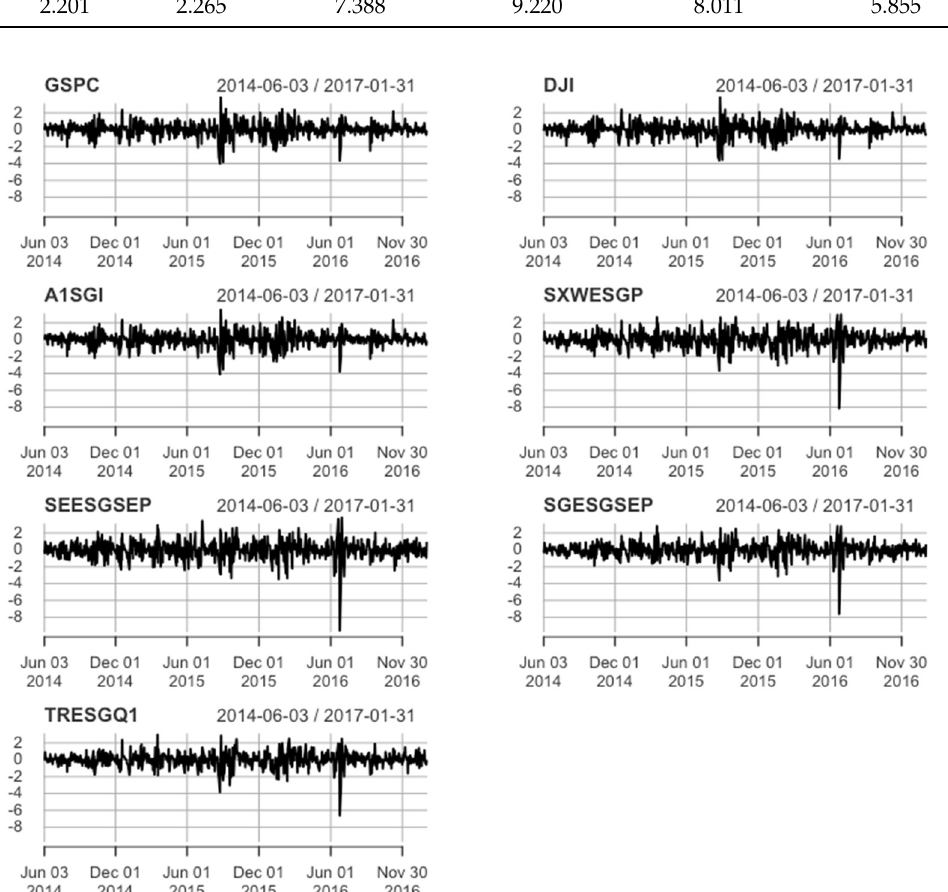
Figure 5. The rates of return, 3 June 2014–31 January 2017. The dependences between the S&P 500 and ESG indices and between the DJI and ESG indices were modeled by the Clayton–Gumbel and t copulas (see Tables 8 and 9). The dependence between S&P 500 and A1SGI compared to the DJI dependence was modeled differently. For example, the GSPC–A1SGI relationship is modeled by Student’s t copula, and DJI–GESGSEP by Clayton–Gumbel